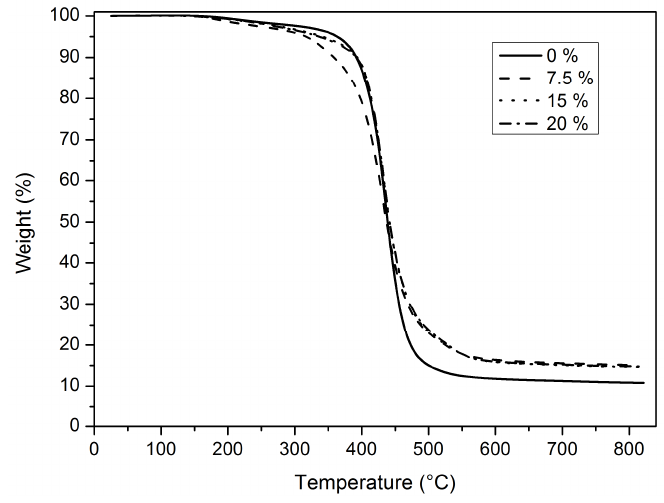
Figure 6. Thermo ‐ gravimetric analysis (TGA) thermograms of the hybrid films. Table 4. Thermal analysis results of UV curable hybrid films.